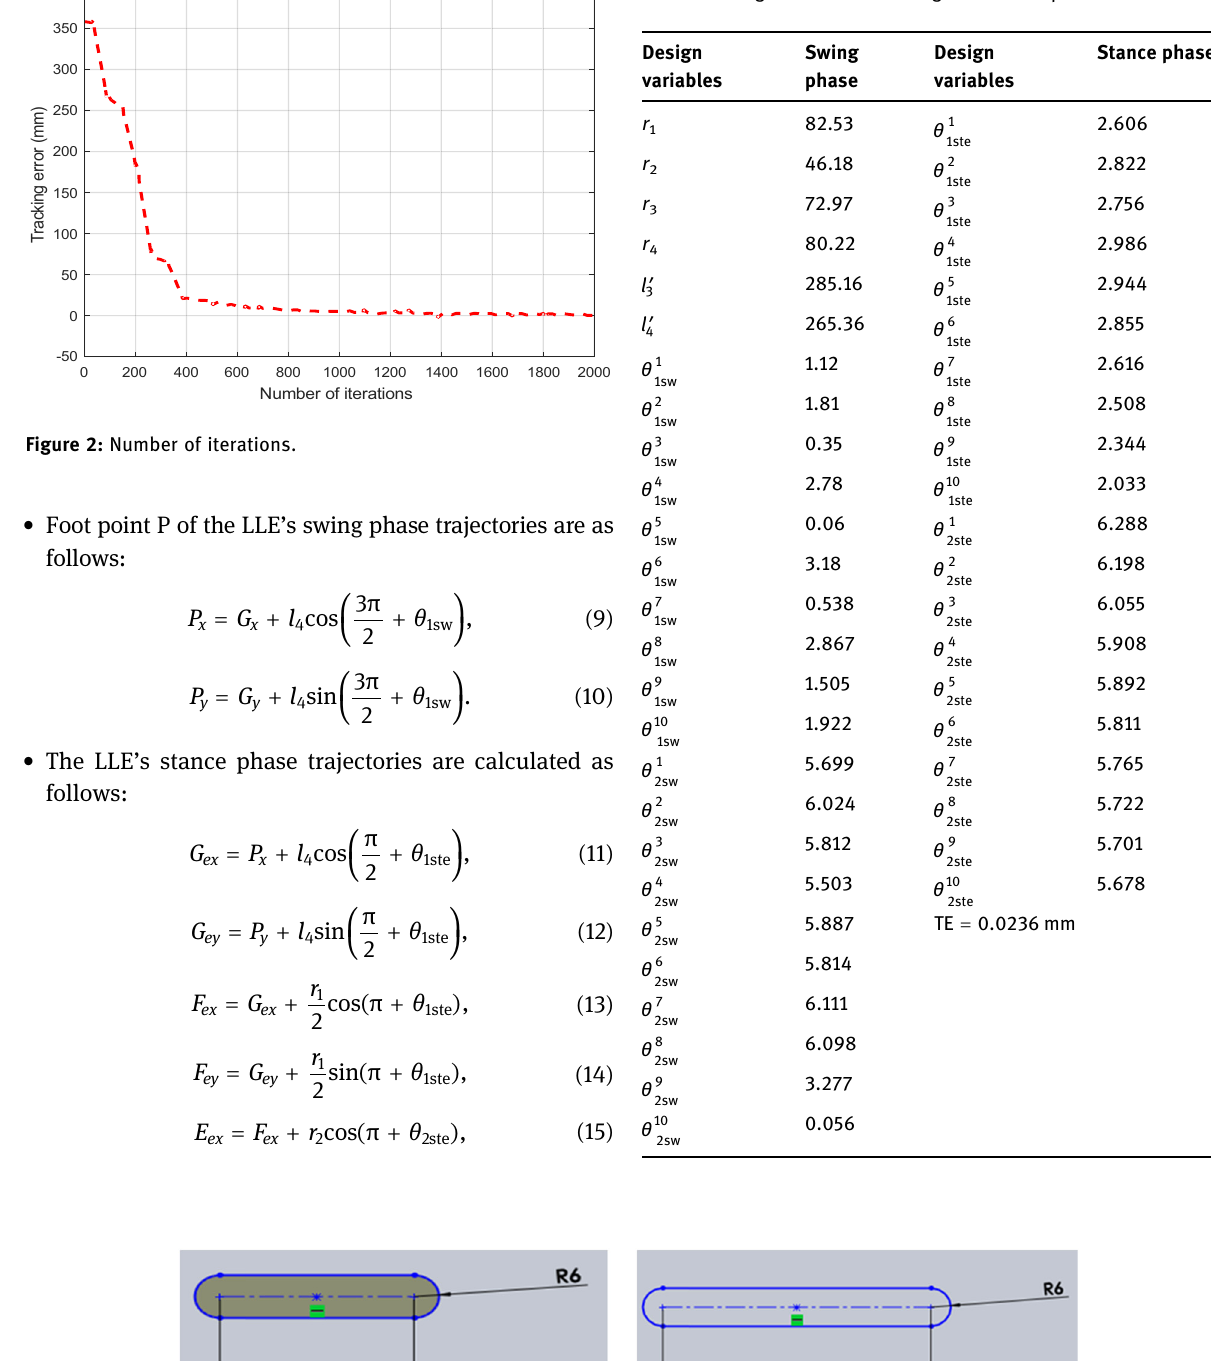
Table 1: Design variables at swing and stance phase